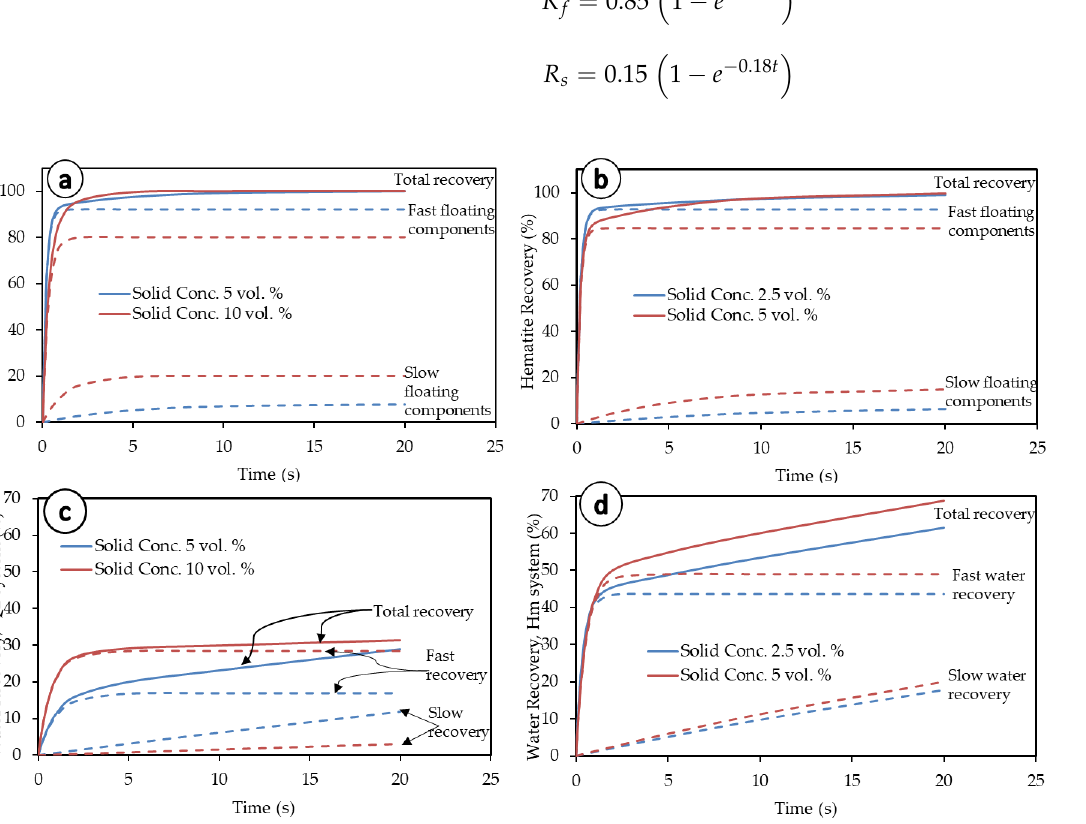
Figure 8. Illustration of fast- and slow-floating components in both the quartz and hematite systems ( − 38 µm fraction). ( a ) Quartz recovery, ( b ) hematite recovery, ( c ) water recovery from Quartz flotation, and ( d ) water recovery from hematite flotation.